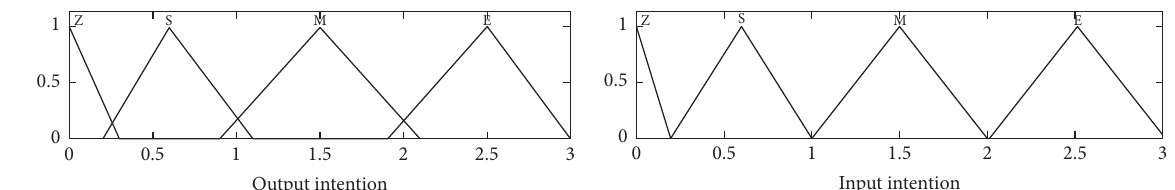
Figure 5: The membership function about output and input braking intention.